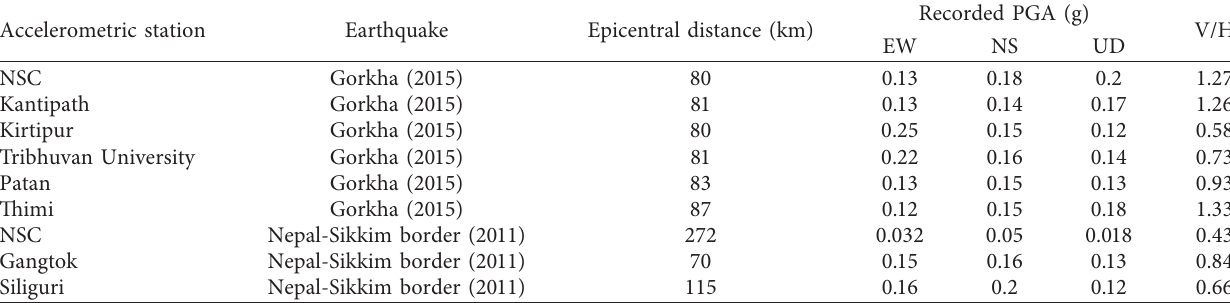
Table 1: Summary of strong motion records after some Himalayan earthquakes (modified from [113–115]). Accelerometric station